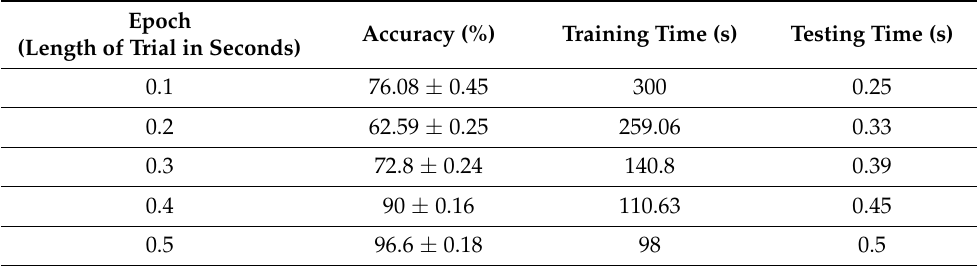
Table 1. Performance of the proposed method with different epoch